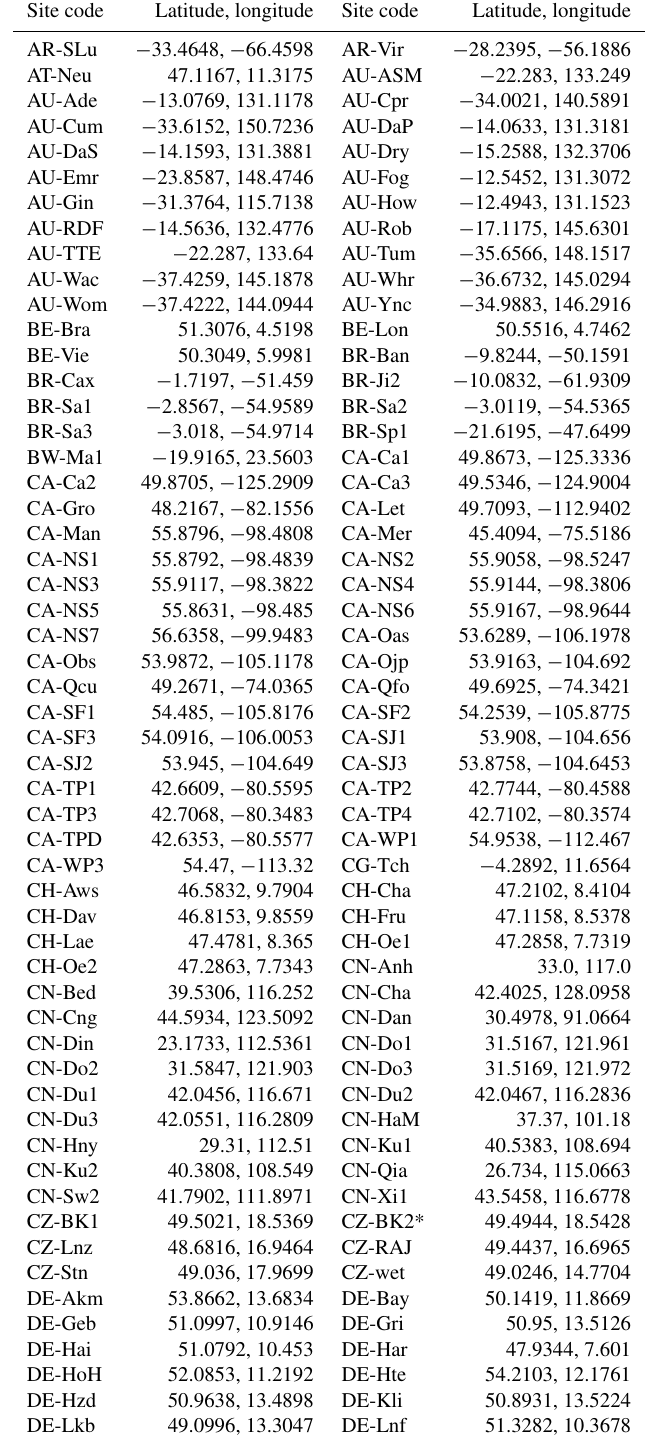
Table E1. Sites in FluxnetEO product version 1.0: site codes and coordinates (rounded to four decimals). Site codes including a ∗ indicate sites for which currently only MODIS data are